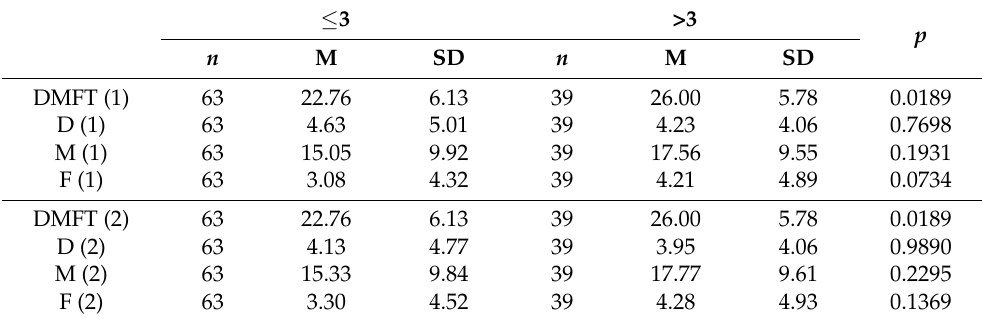
Table 11. Duration of the disease and DMFT index before (1) and after (2)